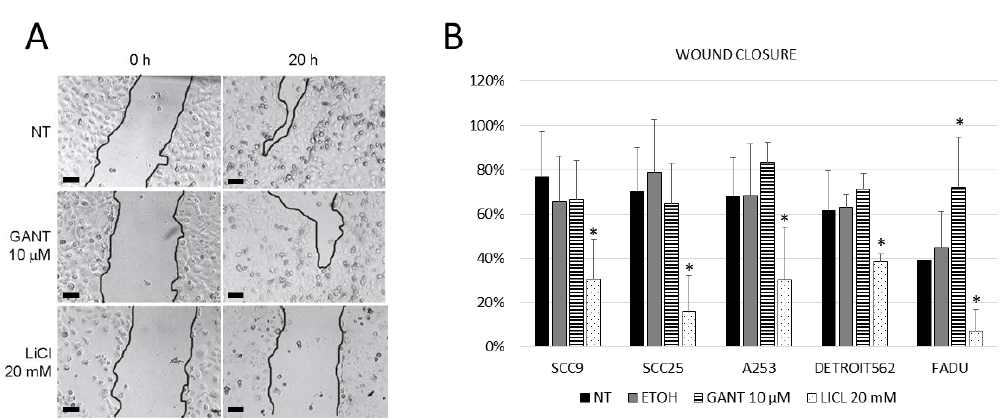
Figure 6. The wound healing assay. ( A ) Digital photographs of wound healing processes (scale bar=200 μ m). ( B ) Quantification of wound closure. GANT61 inhibition has almost no effect on the wound closure compared to the non-treated cells (NT), with the exception of a slight increase in wound closure for the Detroit562 and FaDu cell lines. LiCl treatment inhibits wound closure capability in all cell lines. EtOH—vehicle control. * denotes statistically significant difference from non-treated (NT) cells ( p < 0.05).